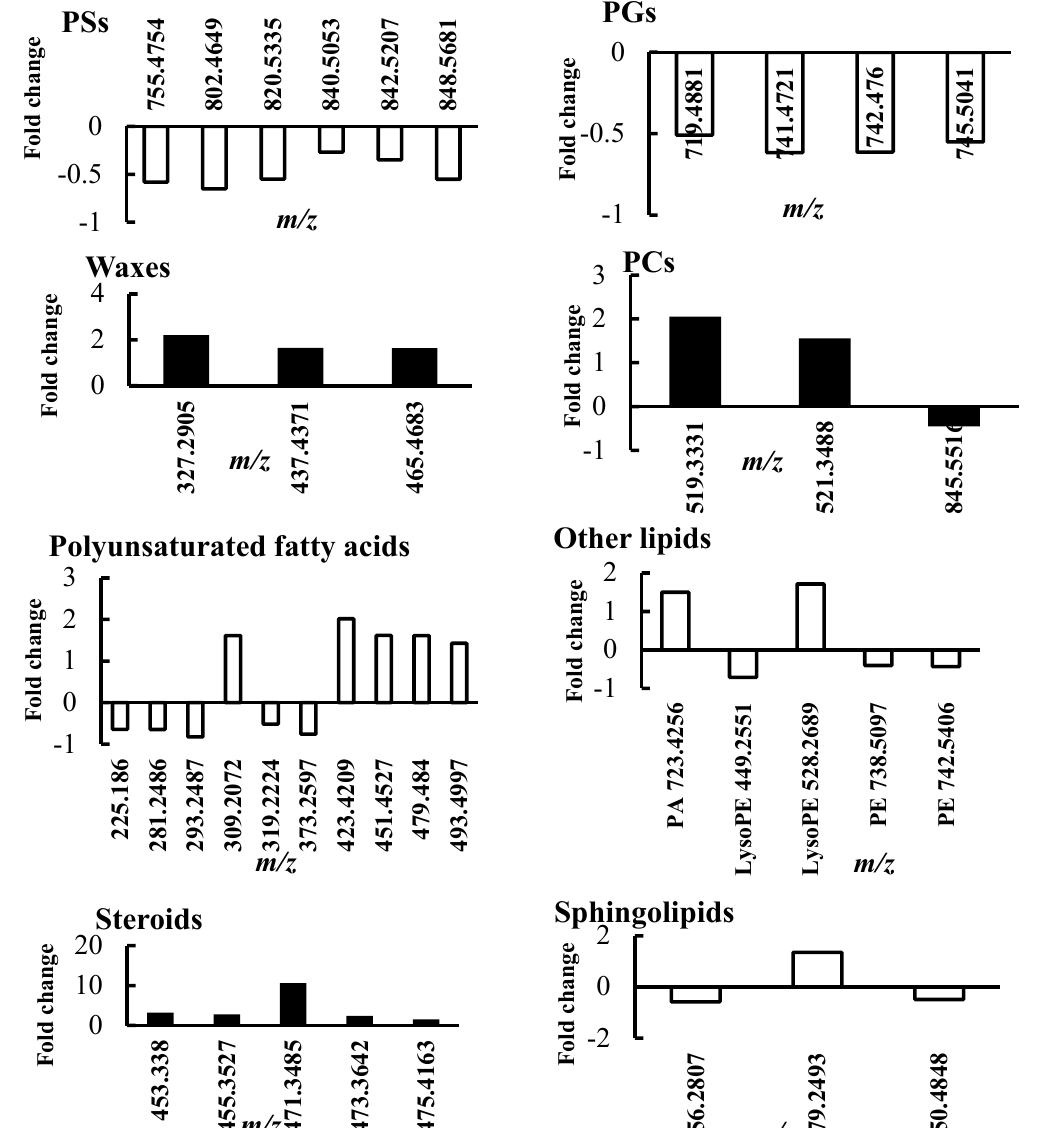
Figure 2. Lipid composition changes in sensitive thyme plants under drought conditions. After water withholding, thyme leaves were harvested and non-polar extracts analyzed by direct infusion Fourier transform ion cyclotron resonance (DI FT-ICR) mass spectrometry. Vertical axis represents the fold change between the control and stressed plants. The mass-to-charge ( m / z ) values are reported next to each bar (abbreviations: MGDGs, monogalactosyldiacylglycerols; DGDGs, digalactosyldiacylglycerols; PS, phosphatidylserine; PG, phosphatidylglycerol; PC, phosphatidylcholine).